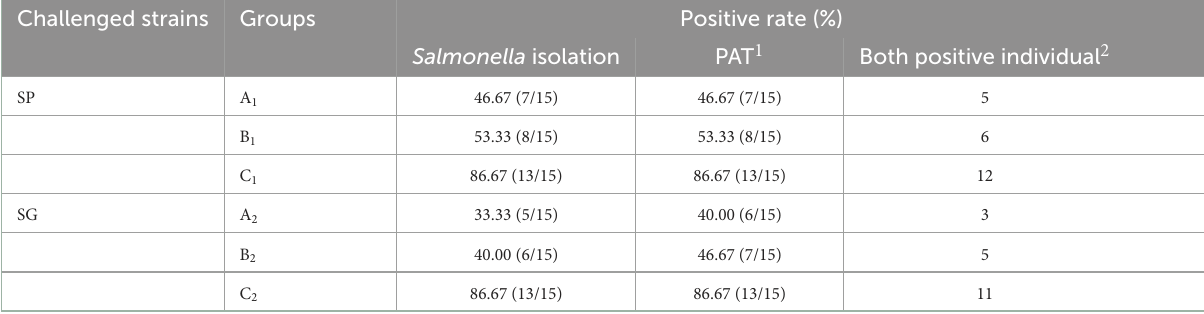
TABLE 3 Comparison of the positivity rate of the Salmonella and the PAT positivity. Challenged